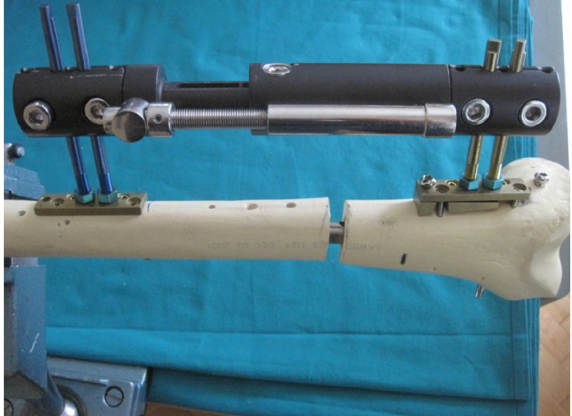
Figure 1. ONAS-DPS: a retrograde femoral IM nail and unilateral frame are shown on the bone model. Two Schanz screws are fixed proximally and distally (Figures 2 and 3) into the plate. Note that the screws are not entering the underlying cortical bone and in this way the contact with IM nail is avoided. A wedge subplate is used distally. In the case of anterograde IM femoral nail (not shown) the ‘‘wedge plate’’ is used proximally. The most distal screw goes through the IM nail in order to provide adequate stability of the whole system.